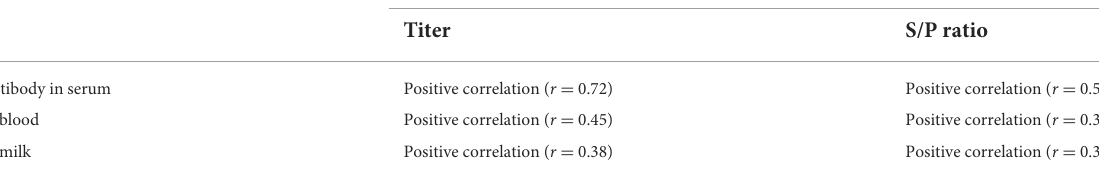
Anti-BLV antibody in whey